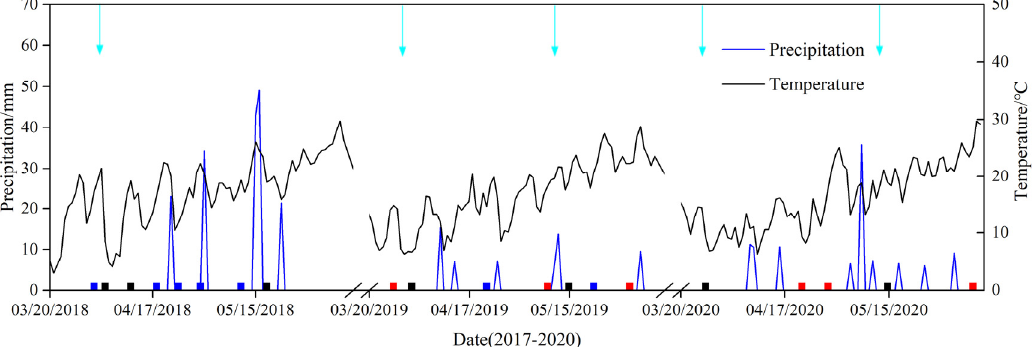
Figure 1. Variations in precipitation and temperature during the experiment period. The downward arrows represent irrigation. The squares represent the sampling dates under different soil water content conditions: wet (black), dry (red) and normal (blue). Table 1. Basic physical properties of the 0–100 cm soil profile.